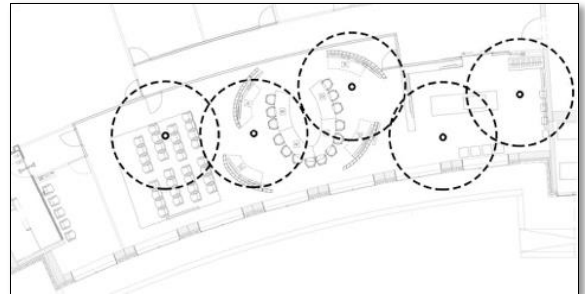
Figure 3: Range of the individual receivers on the floor, based on the conical angle